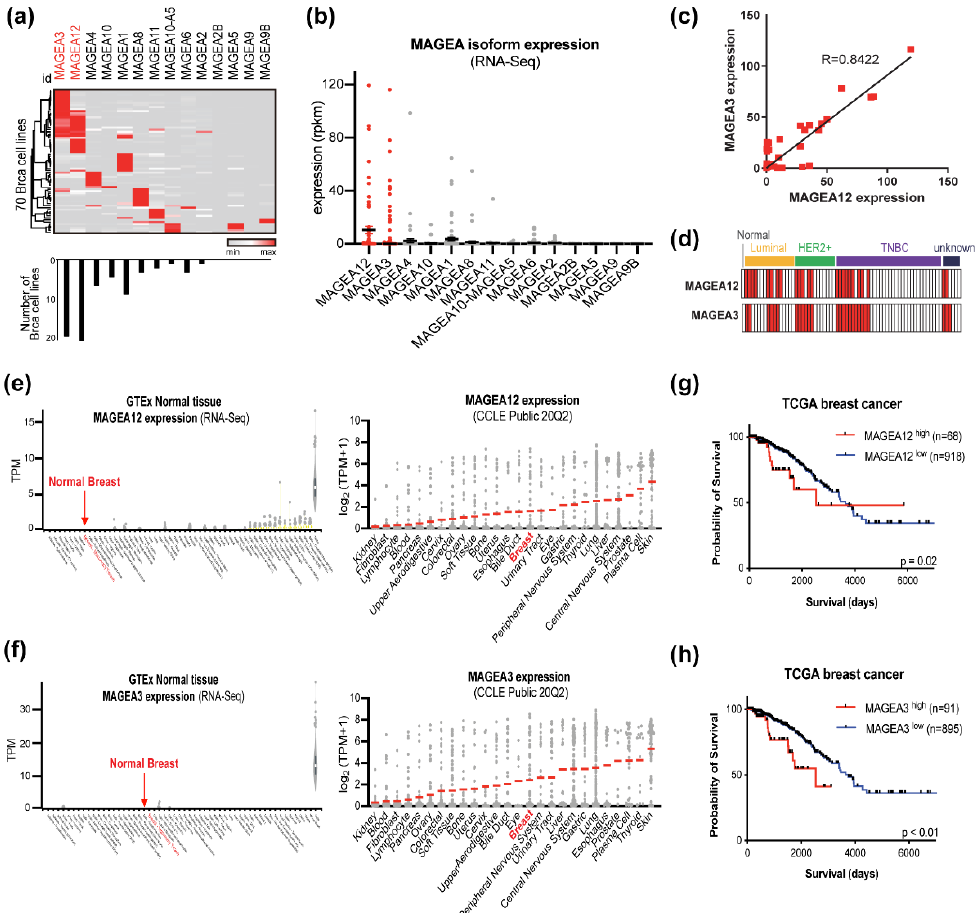
Figure 1. Expression of MAGE-A family genes in breast cancer cell lines. ( a ) A heat map ( top ) shows the expression pattern of the MAGE-A isoforms in 70 breast cancer cell lines. A plot ( bottom ) shows the numbers of breast cancer cell lines that expressed each MAGE-A isoform (defined as rpkm > 5 MAGE-A expression). Thus, there were 18, 19, 8, and 6 cell lines that expressed MAGEA3, MAGEA12, MAGEA1, and MAGEA4, respectively. ( b ) MAGE-A isoform expression levels in 70 breast cancer cell lines, as determined from RNA-seq data. MAGEA12 had the highest median expression value. ( c ) Correlation between MAGEA12 and MAGEA3 expression in the 70 cell lines (R = 0.8422). ( d ) Relationship between the breast cancer subtypes of the cell lines and their expression of MAGEA12 and/or MAGEA3. No relationship was observed. ( e ) Expression levels of MAGEA12 in normal tissues (GTEx) and cancer cells (CCLE). ( f ) Expression levels of MAGEA3 in normal tissues (GTEx) and cancer cells (CCLE). ( g , h ) Kaplan-Meier analysis of the overall survival of 986 breast cancer patients who were stratified into two groups depending on whether MAGEA12 ( g ) and MAGEA3 ( h ) expression was ‘high’ (red) and ‘low’ (blue). The stratification was conducted with an autoselected best cutoff.